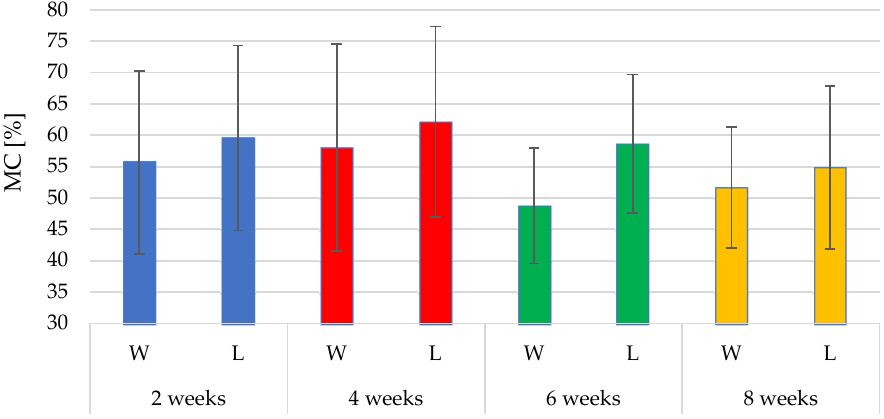
Figure 4. Mean and standard deviation of MC according to storage duration, and storage methods. The average of sapwood and heartwood data. W—scenario W (whole trees), L—scenario L